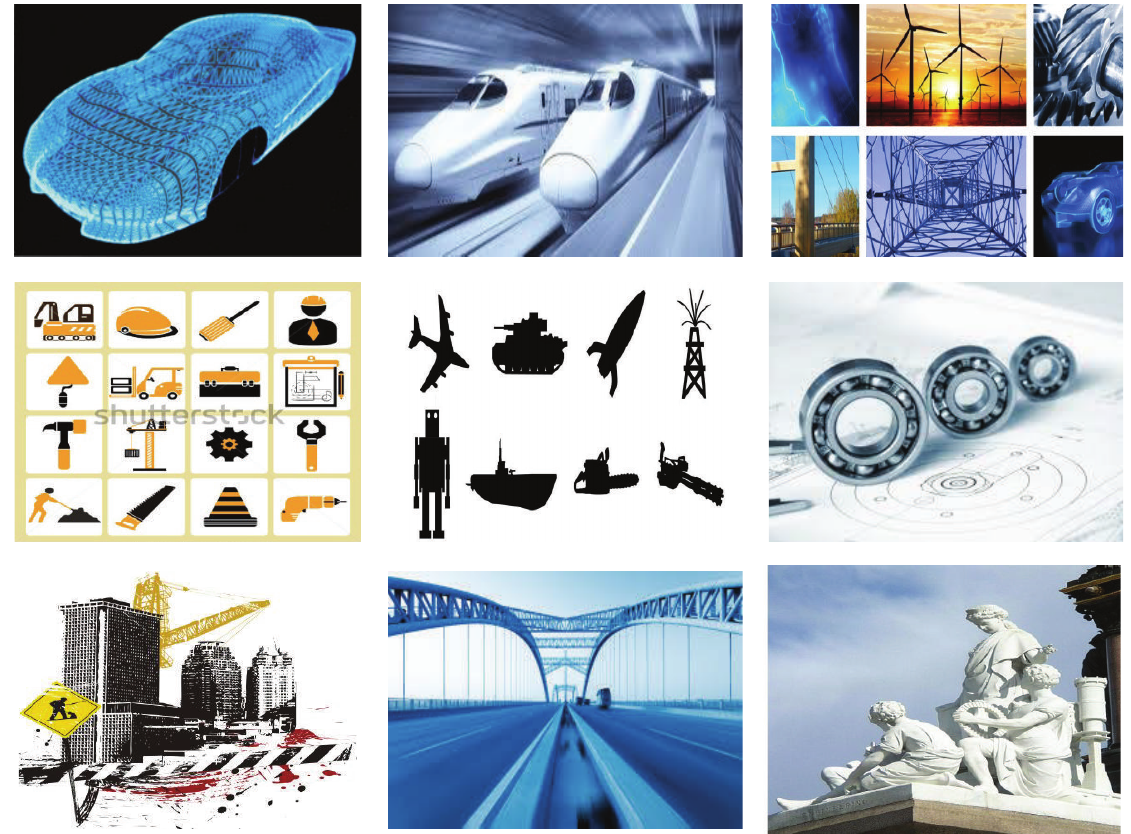
Figure 1: Some of the engineering